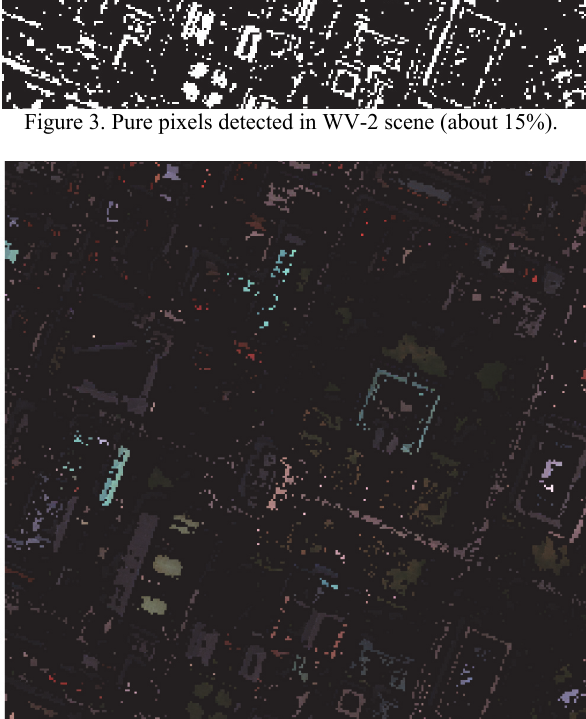
Figure 4. Reconstruction of pure pixels using